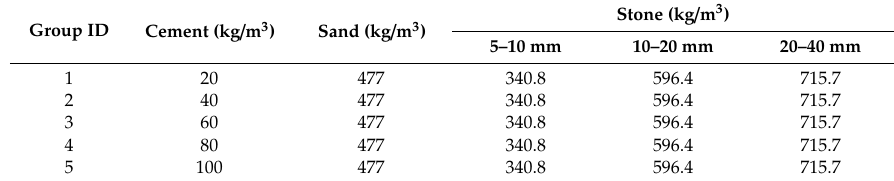
Table 3. Details of the test specimens.